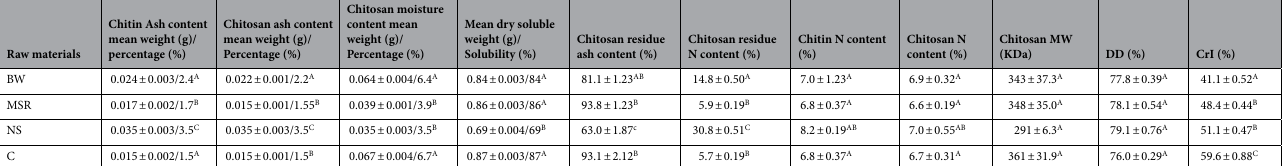
Table 2. Physiochemical properties of chitin and chitosan isolated from locally available materials. Mean values in each column accompanied by the same letter are not significantly different ( P > 0.05) (Tukey Multiple Comparison) and values accompanied by letter (s) which are not similar are significantly different ( P < 0.05), N represents Nitrogen, g: gram, BW: Banana weevil, MSR: Mushroom, NS: Nile perch scale, C: Commercial, MW: Molecular Weight, KDa: Kilo Dalton, DD: Degree of Deacetylation and CrI: Crystalline